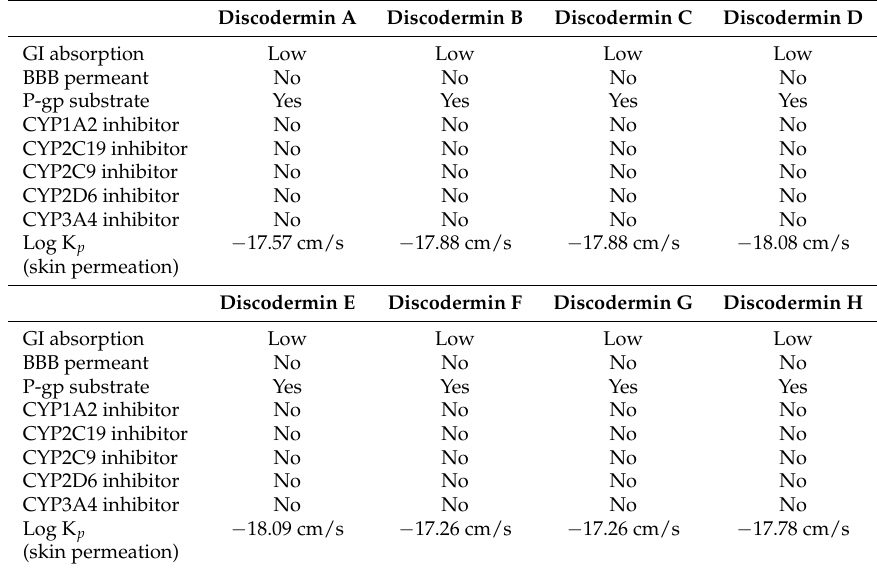
Table 2. Absorption, Distribution, Metabolism, and Excretion (ADME) parameters related to Discodermin A–H